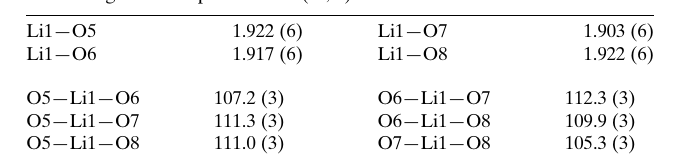
Table 3 Selected geometric parameters (A˚ , (cid:4) ).